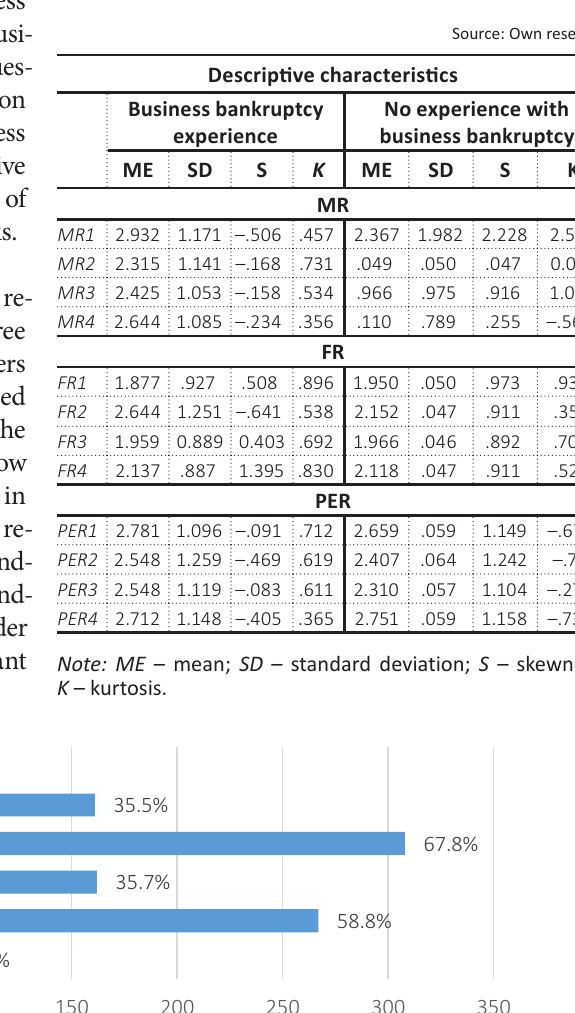
Table 1. Selected descriptive characteristics of